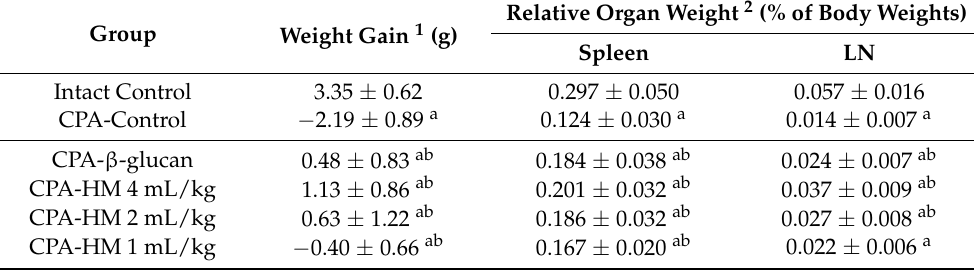
Table 1. Changes in weight gain and relative organ weights following hemomine treatment in intact or CPA-induced immunosuppressed mice.